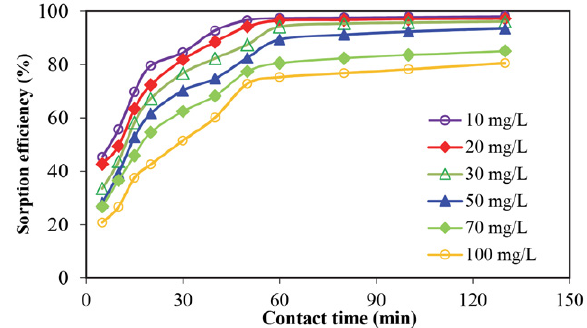
Figure 8. Impact of contact time in various concentrations of P ion on the removal efficiency (Conditions: pH = 6, mixing rate = 500 rpm, adsorbent dosage = 2 g/L, and temperature = 55 o